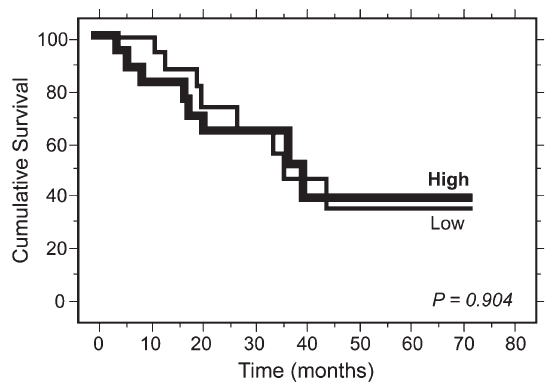
Fig. 3. Event-free survival curves in 34 high-grade osteosarcoma patients, stratified according to the MGST gene expression level at diagnosis.ApooledcDNAfromhumannormalosteoblastswasused as calibrator and patients were stratified into high- or low- expres- sors by using the median MGST gene expression value as cut-off. Comparison of survival curves was performed by the log-rank